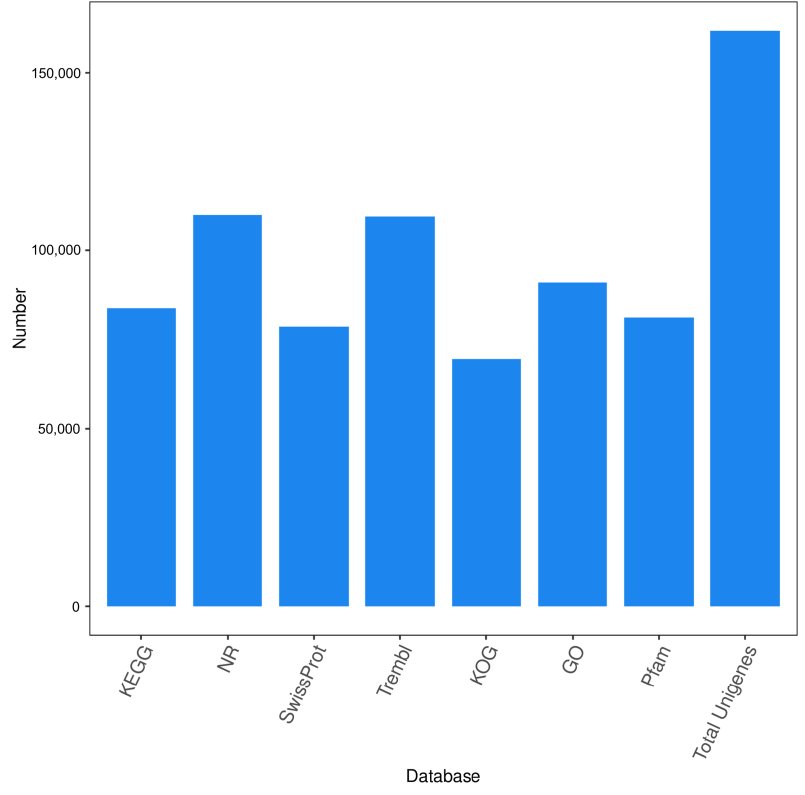
Figure 3. Statistical map of the number of unigene annotations obtained from all the ‘Feizixiao’ litchi samples by comparing to KEGG, NR, SwissProt, TrEMBL, KOG, GO, and Pfam databases in 2020.